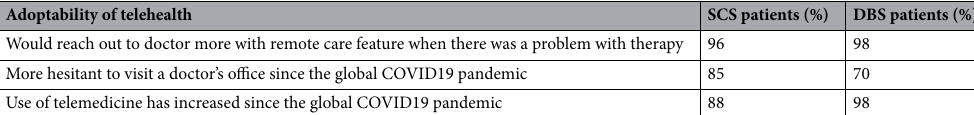
Table 1. Market Assessment of patient readiness to adopt telehealth technologies.